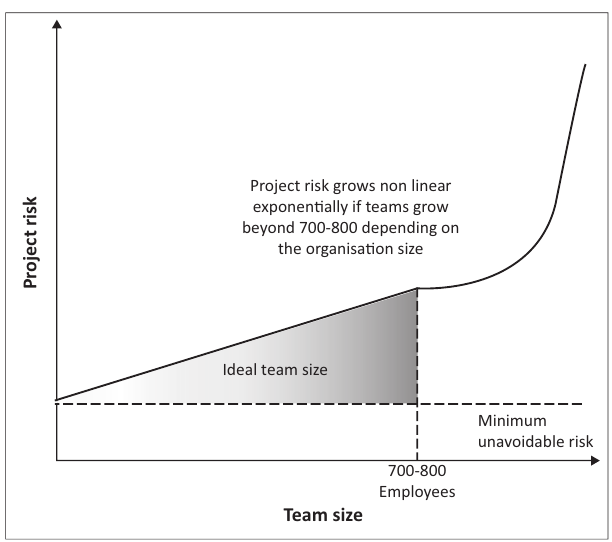
FIGURE 1: The relationship between team size and project delivery risk.